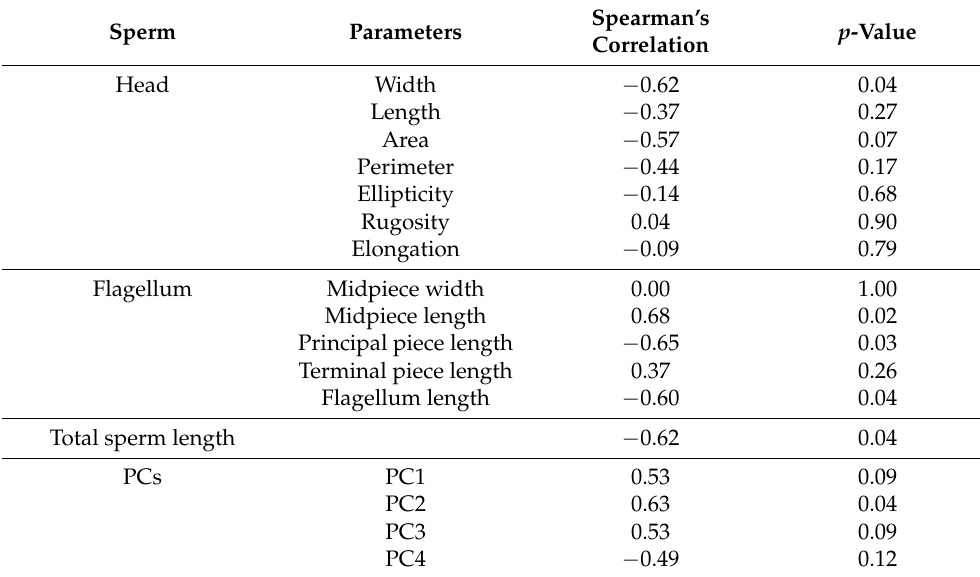
Table 4. Correlation between bottlenose dolphin ( Tursiops truncatus ) sperm morphometry variables and blood testosterone concentrations. A statistical correlation was considered when p < 0.05.